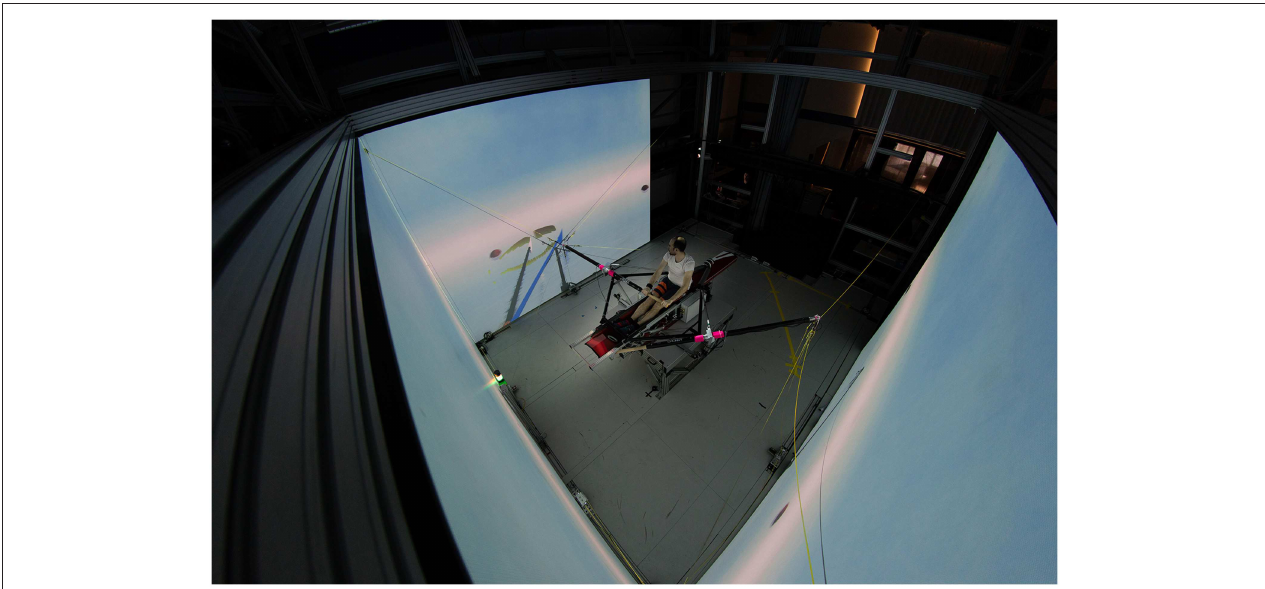
FIGURE 1 | Custom built rowing simulator with a trimmed single scull boat in the middle and screens surrounding it. The person sitting in the boat is the first author of the paper. He demonstrates the visual scenario and the augmented visual feedback that is provided during the training